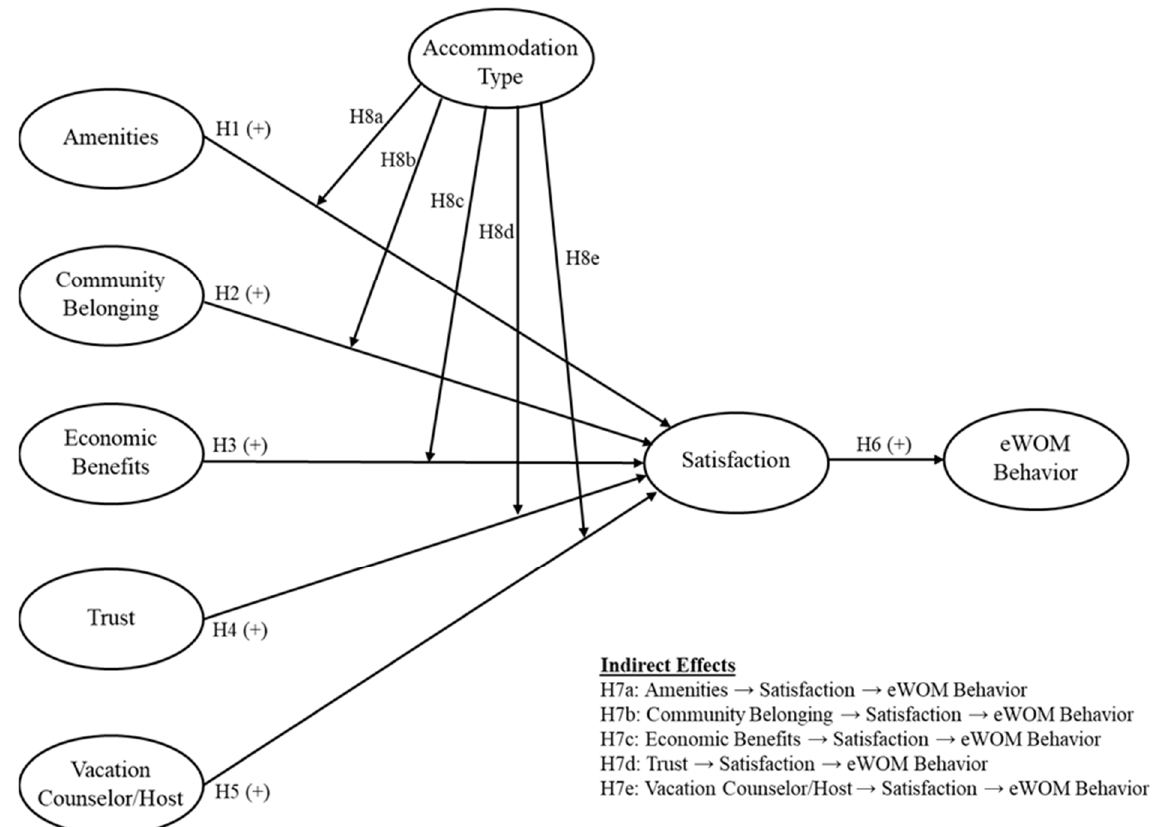
Figure 1. Conceptual